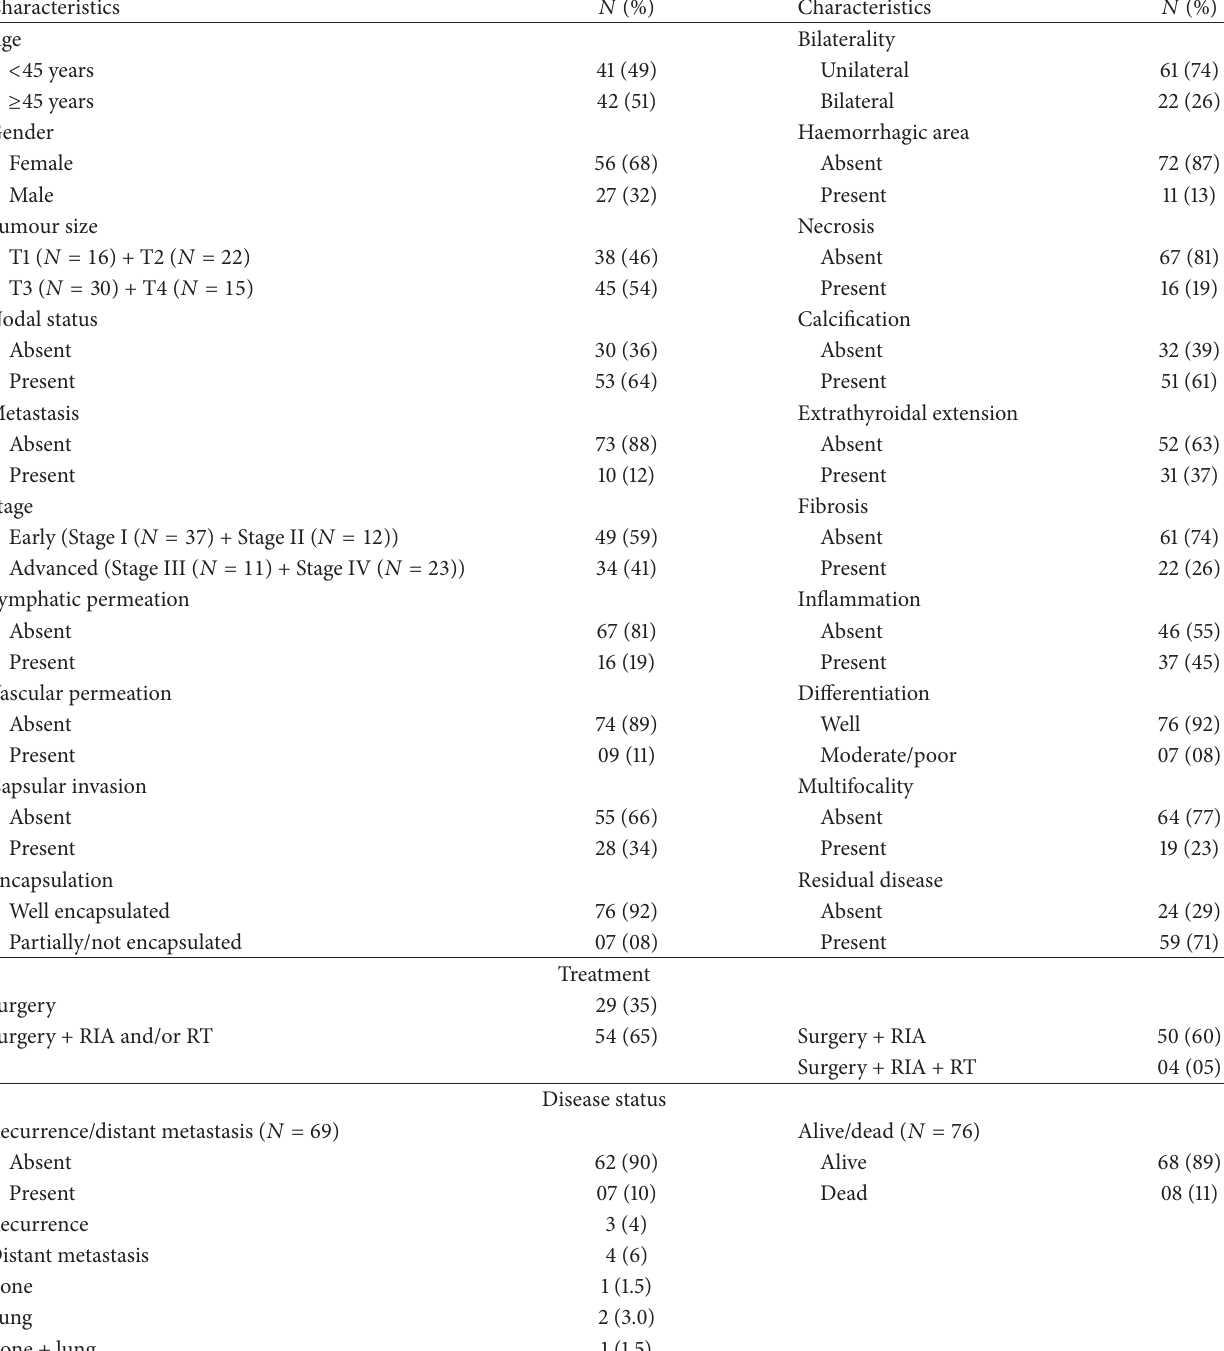
Table 1: Clinicopathological characteristics of PTC